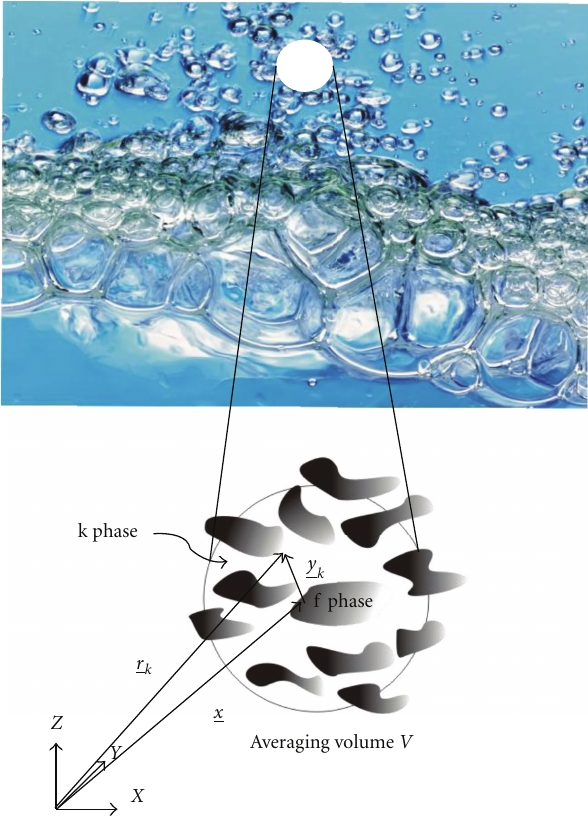
Figure 1: Schematic figure of a two-phase flow with a transition region, showing the position vectors and the averaging